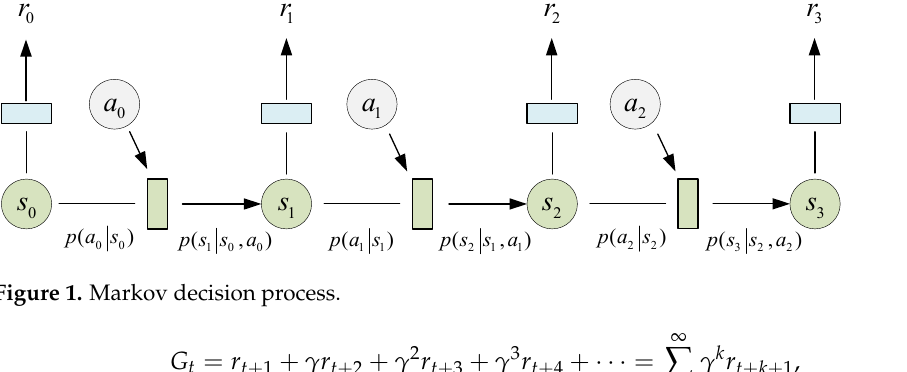
Figure 1. Markov decision process.